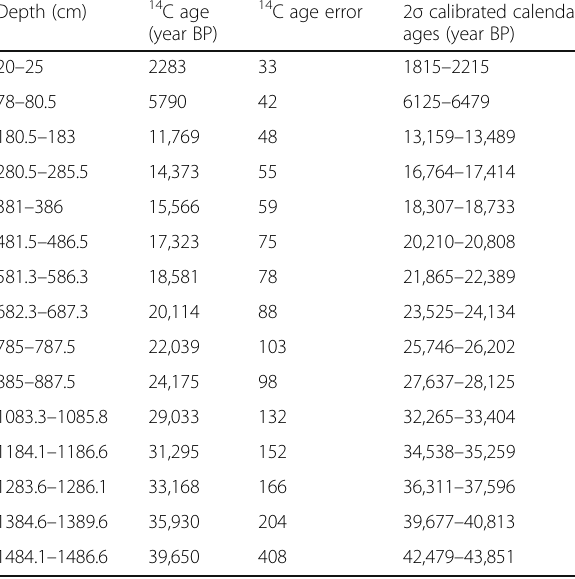
Table 2 Results of AMS radiocarbon and calendar ages Depth